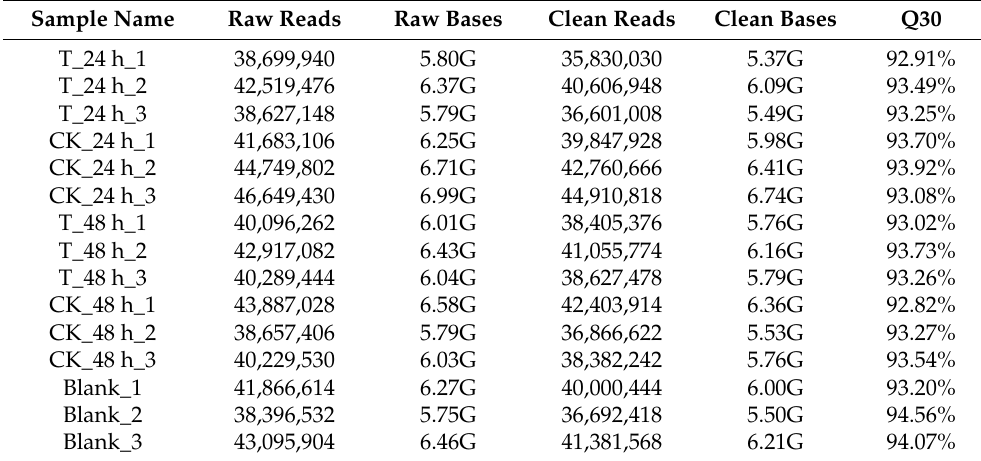
Table 1. Statistical summary of S. furcifera groups, after having inoculated M. anisopliae or